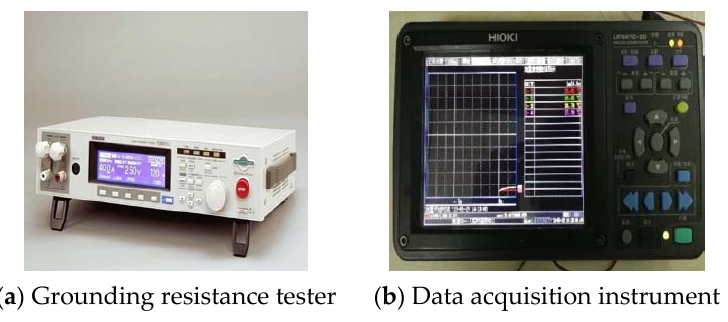
Figure 5. Equipment used in this study.